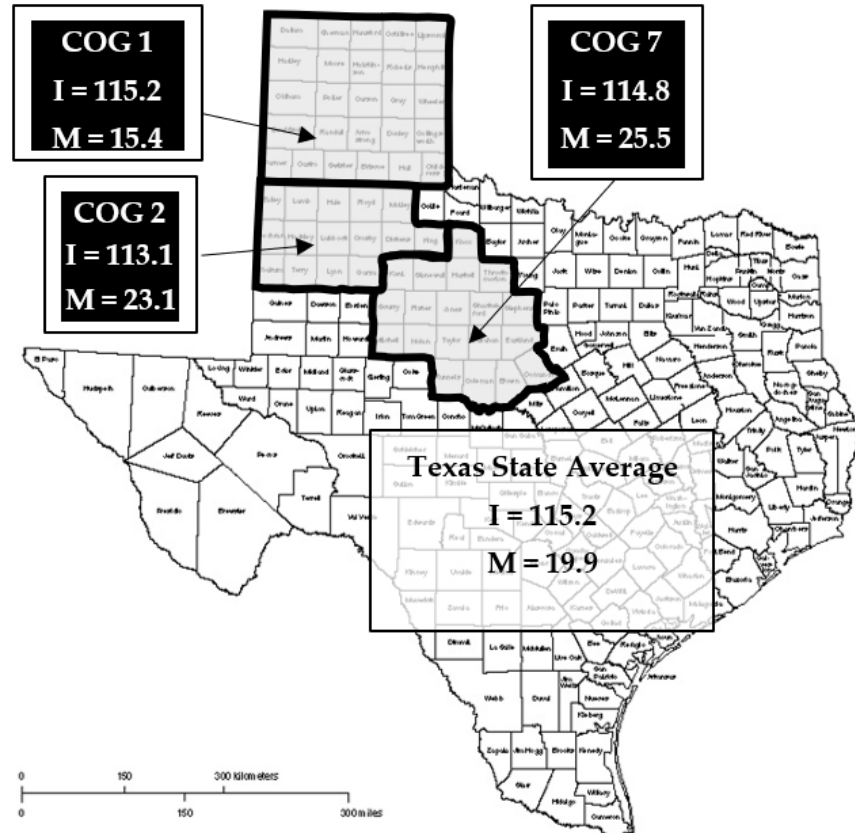
Figure 1. Target region for Access to Breast Care for West Texas (ABC4WT). Outlines mark the Council of Government (COG) regions with age-adjusted incidence (I) and mortality (M) rates for breast cancer per 100,000 women compared with the state averages in 2018.